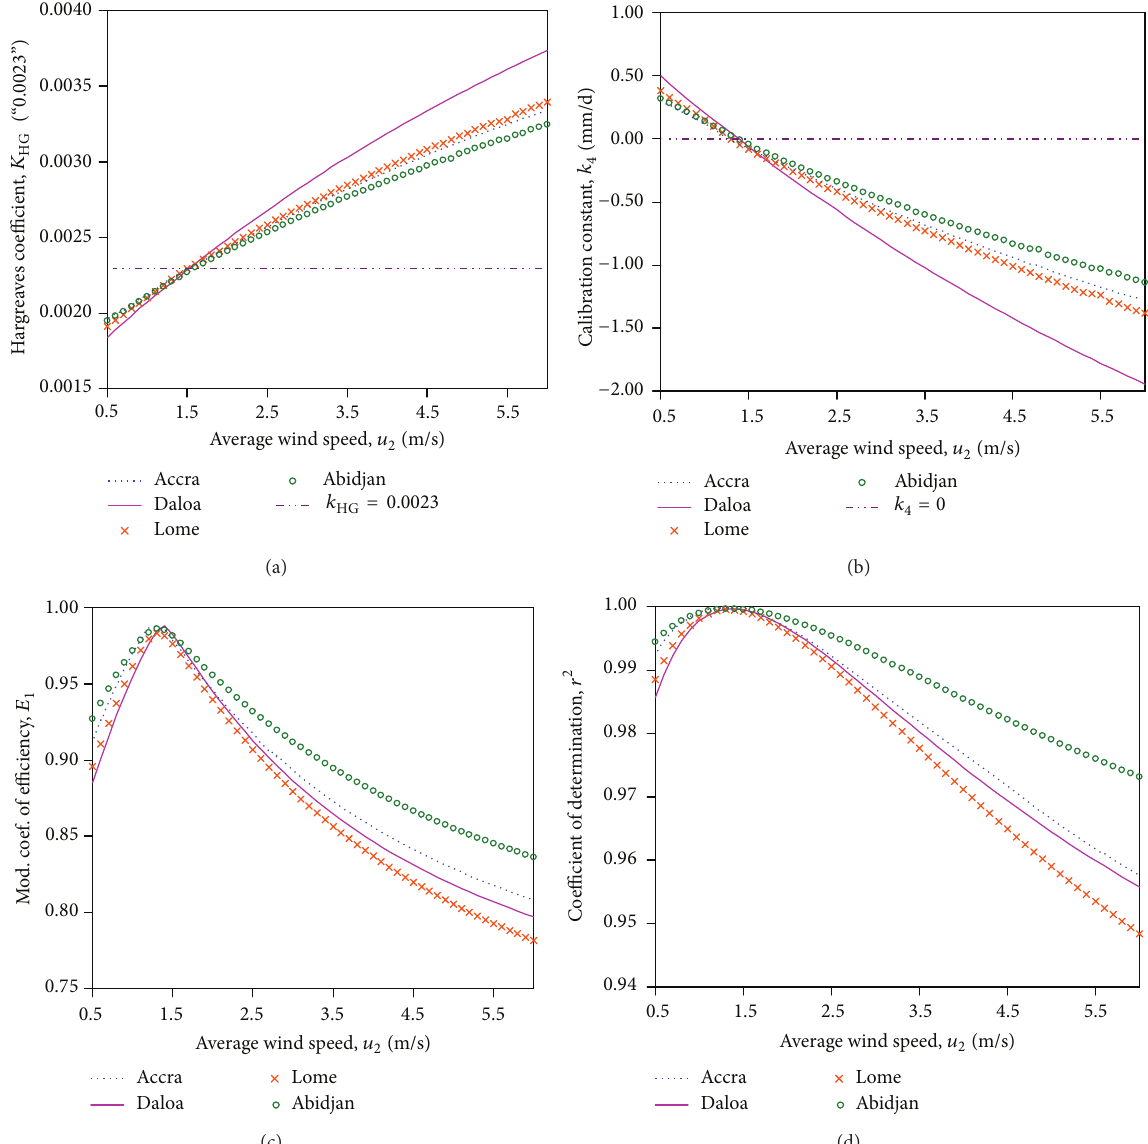
Figure 1: Calibrated optimal values of 𝑘 Daloa, and